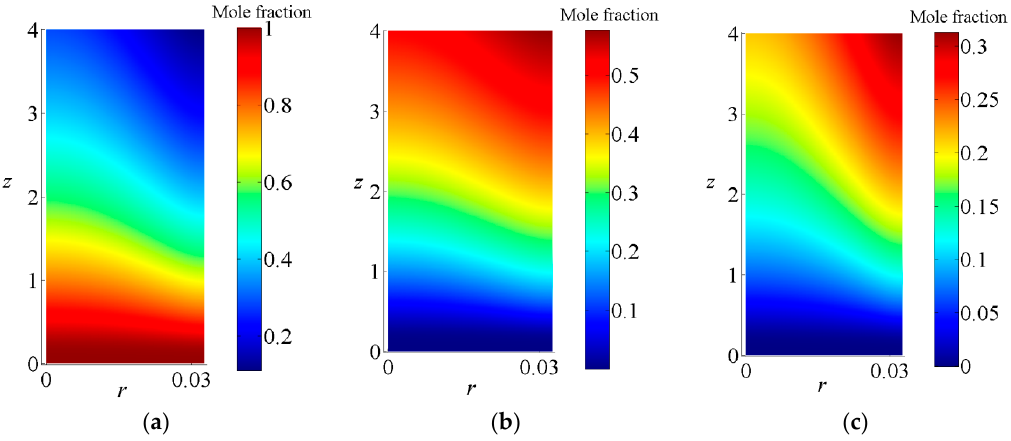
Figure 5. Mole fraction distribution in the catalyst bed. ( a ) CH 3 OH; ( b ) H 2 ; ( c ) CO.